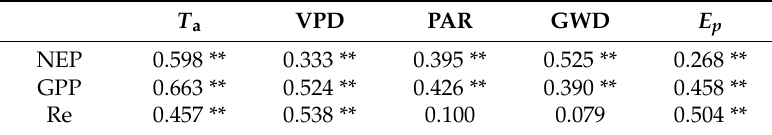
Table 2. Spearman’s correlations between daily net ecosystem production (NEP, g C m − 2 d − 1 ), gross